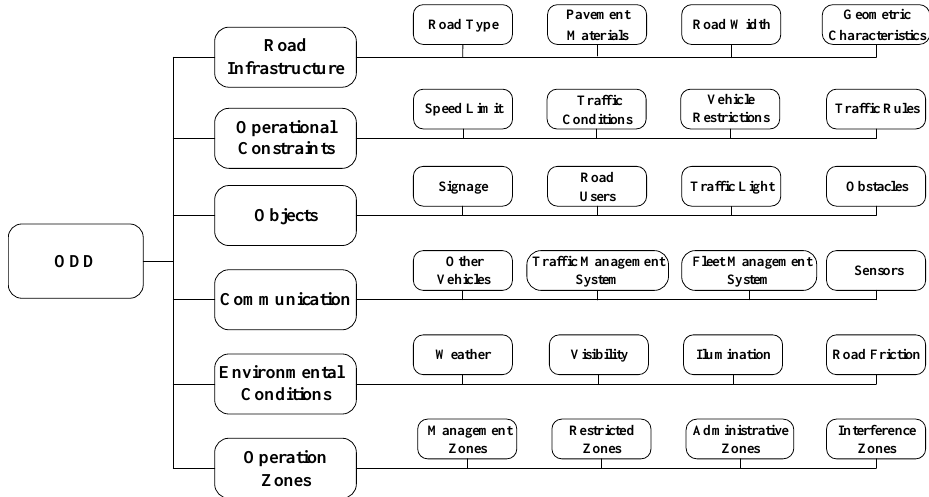
Figure 2. The ODD classification framework with top-Level categories and immediate